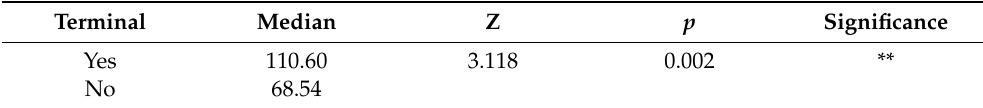
Table 5. Non-parametric test results for “terminal”.